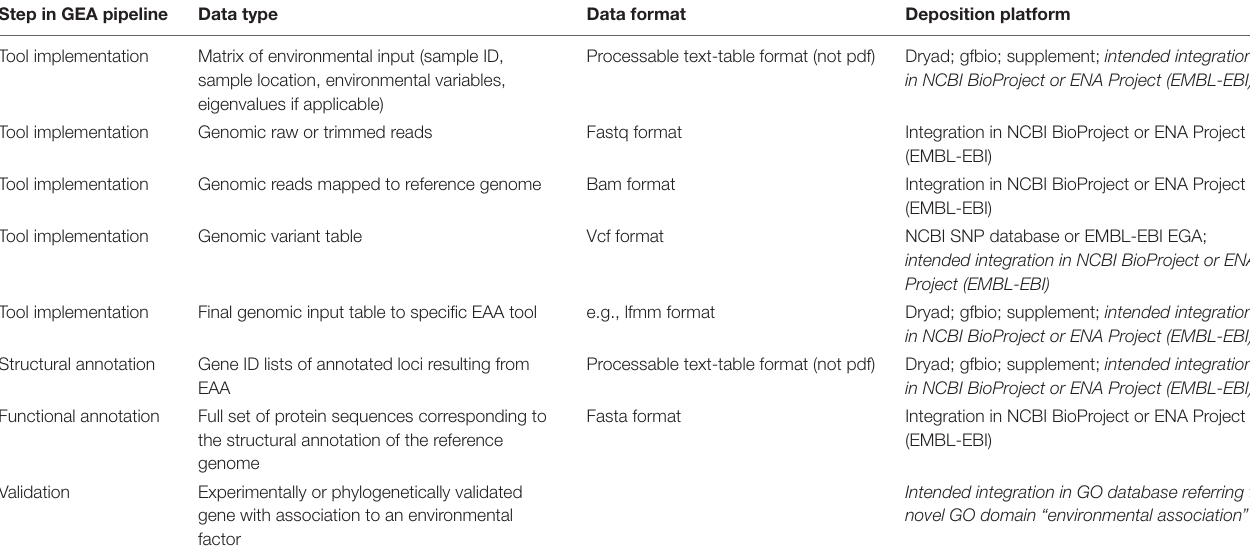
TABLE 1 | Suggested standards for deposition of GEA input and results